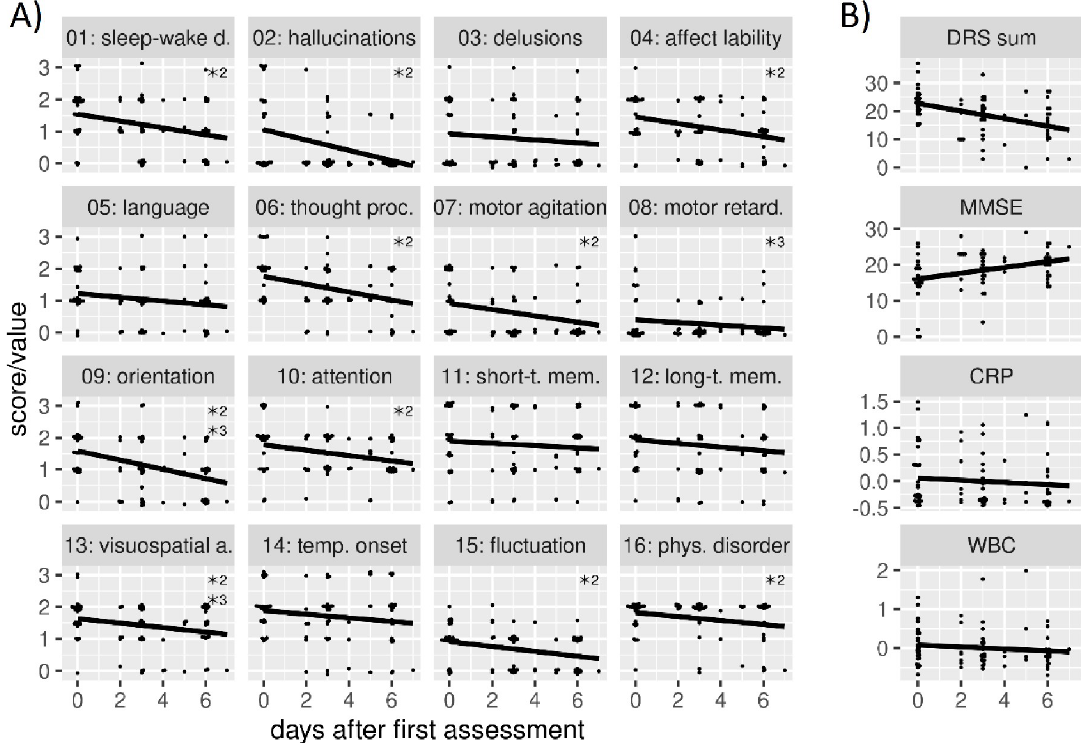
Fig 1. A: DRS-R-98 symptom scores at assessment times. Higher values indicate higher symptom severity. B: DRS-R-98 total score, MMSE, CRP and WBC at assessment times. � 2 = significant effects in the second LME model, � 3 = significant effects in the third LME model. DRS-R-98 = Delirium Rating Scale Revised 98, MMSE = Mini-Mental Status Examination, MMSE = Mini-Mental-Status Examination, CRP = C-reactive protein, WBC = white blood cell count.